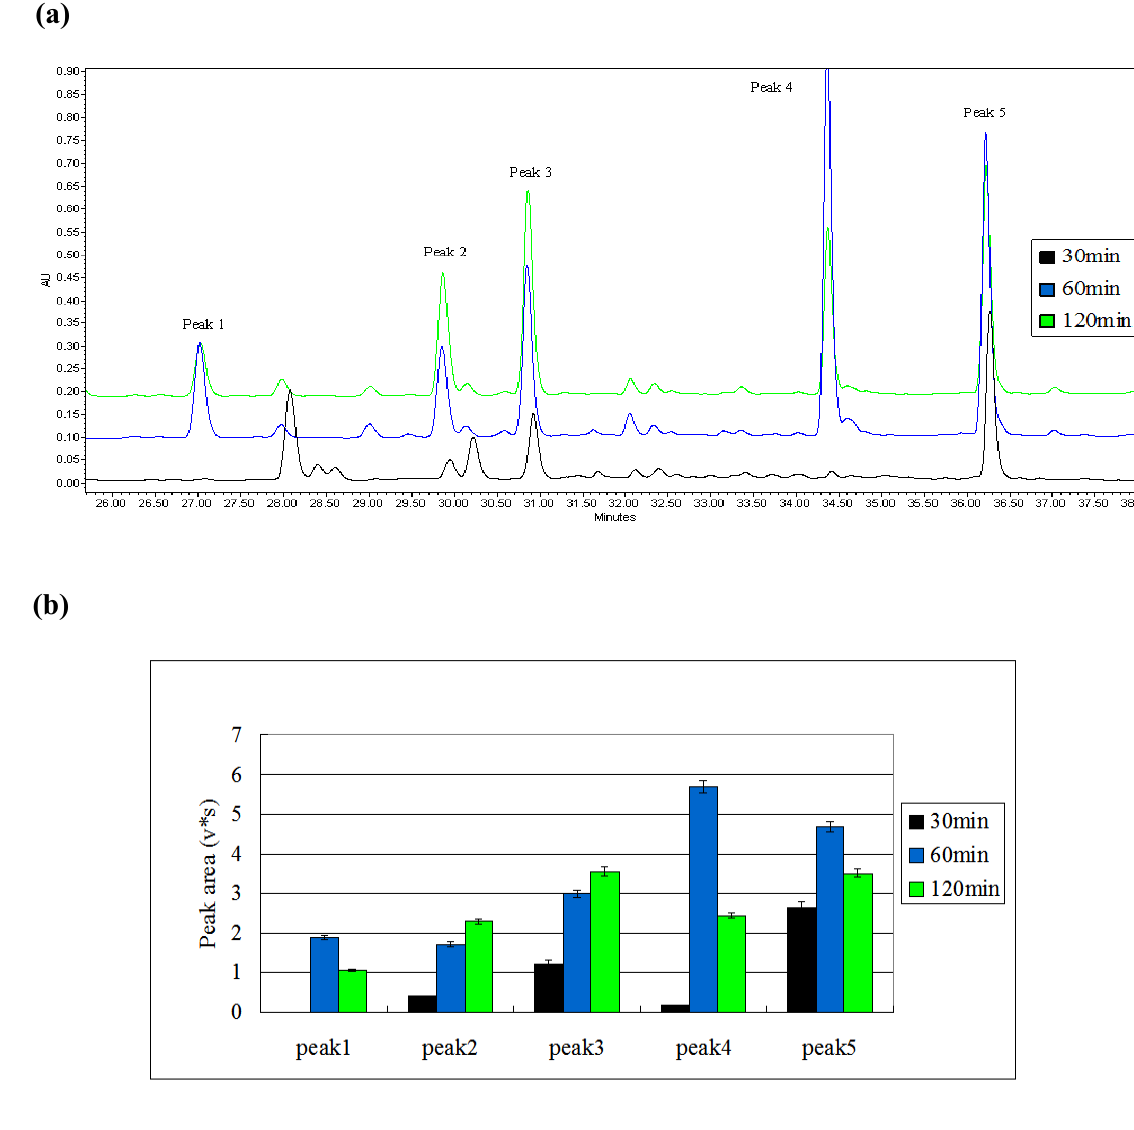
Figure 3. (a) Induced result of different time-period detected by HPLC fingerprint. HPLC chromatograms of the mulberry leaves’ extract induced by different time lengths. The black curve represents the sample of 30min, the blue curve represents the sample of 60 min, and the green curve represents the sample of 120 min. A 250 mm Waters Symmetry C column was utilized for this experiment. (b) Comparison of peak areas of five induced compounds in different time lengths